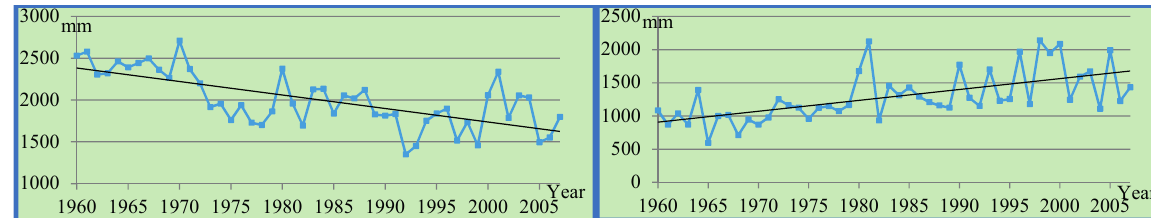
Figure 11. The most significant negative trend with a slope of − 1.3859 ( left ) and the most significant positive trend with a slope of 2.2312 ( right ) of the RX5day index.